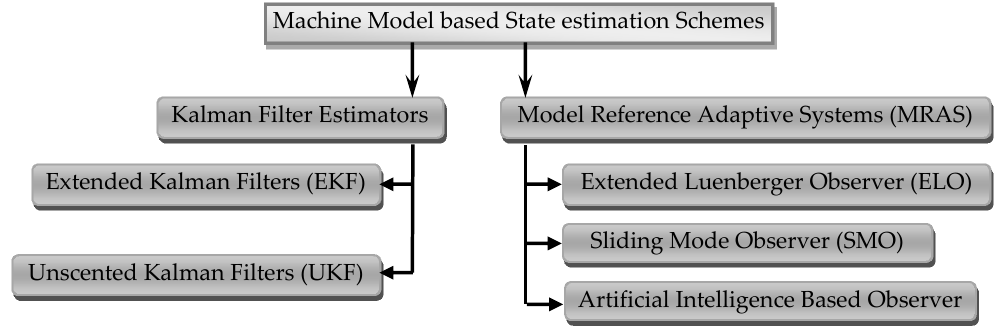
Figure 2. Machine model based state estimation schemes.